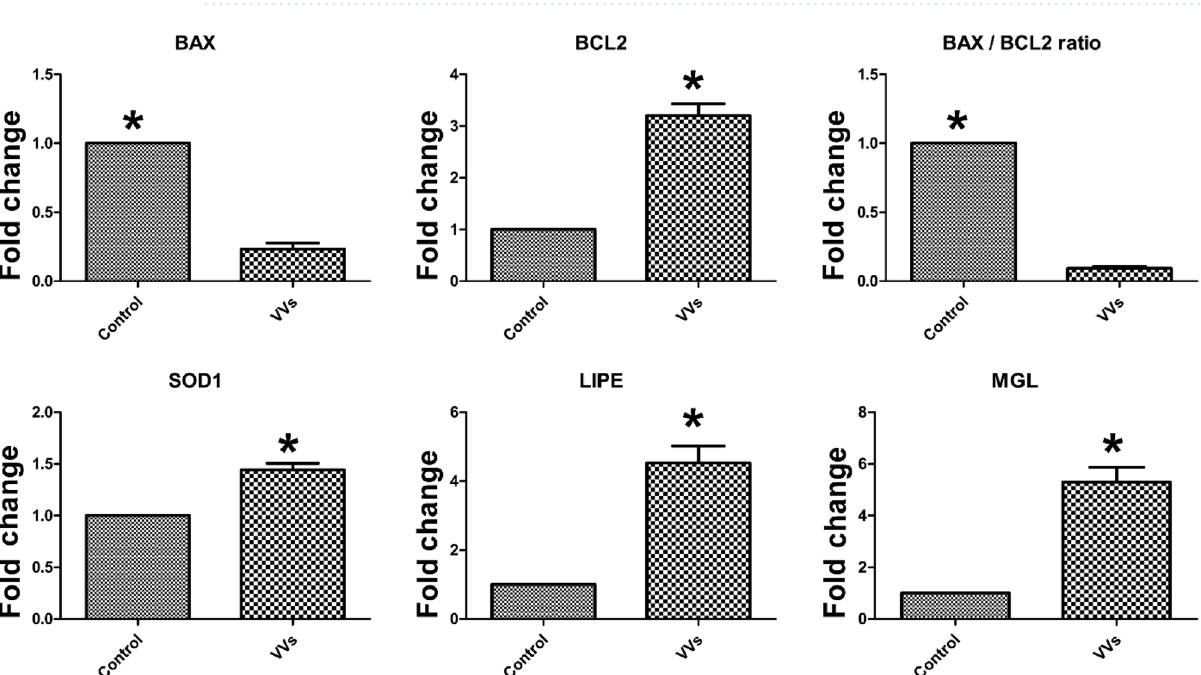
Figure 8. Relative quantitative analysis (RT-qPCR) of mRNA transcripts expressed in the embryos treated with VVs. Five blastocysts from each group of four replicates were used for qPCR analysis. The means were normalized to the control group and expressed as arbitrary units (fold change). Data are expressed as mean ± SD and the difference between the two groups was compared using Student’s t-test. Values denoted by an asterisk (*) are considered statistically significant ( p < 0.05). House-keeping genes ACTB and U6 were used for quantification of the target transcripts through the ΔΔCt